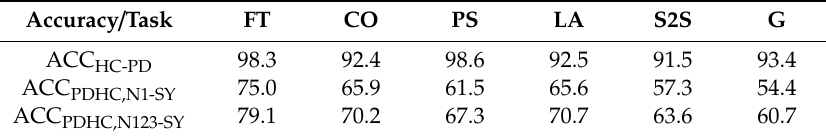
Table 3. Classification accuracies for the six